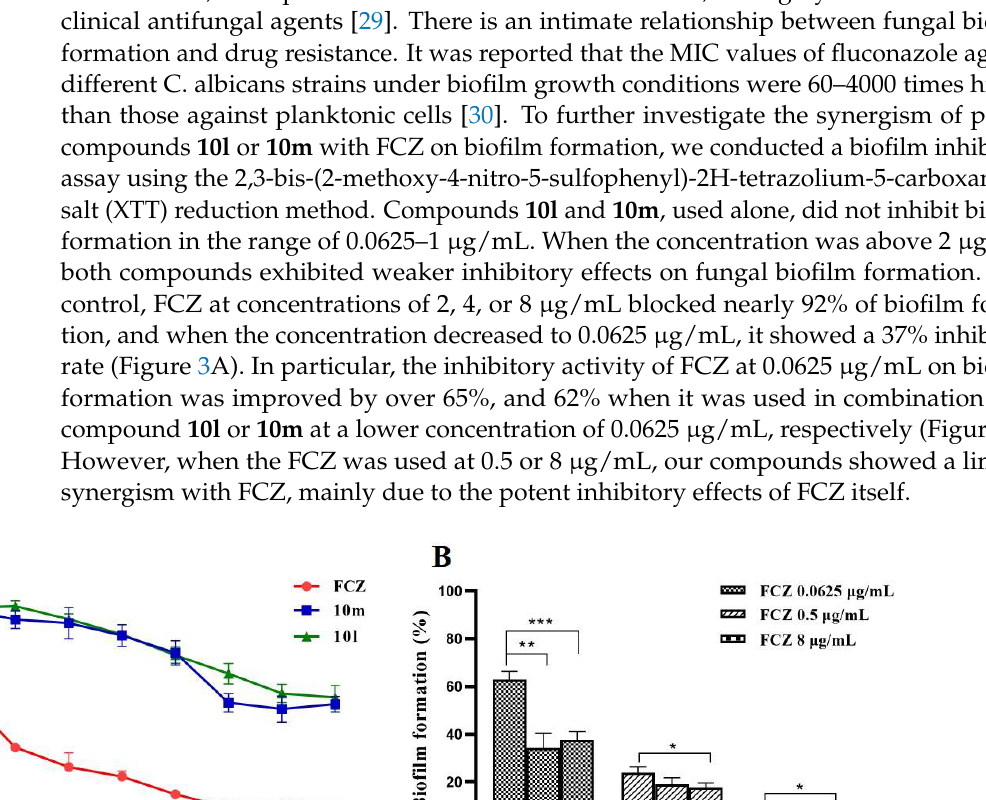
Table 3. Antifungal spectrum of compound 10l (MIC 80 , µ g/mL, 48 h).